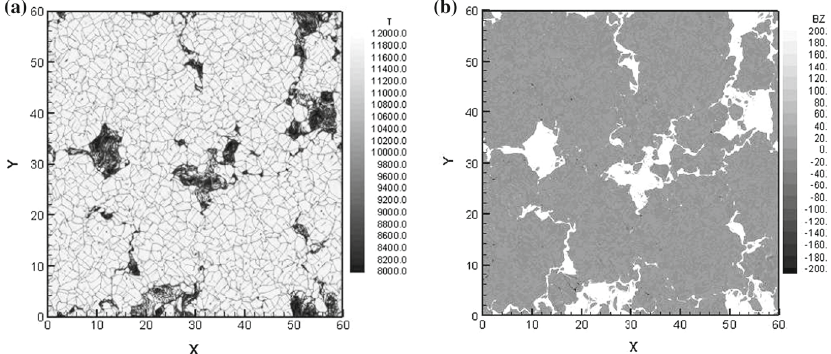
Fig. 16 Horizontal maps of a temperature and b vertical magnetic field fluctuations in the surface layers of local realistic simulations of large-scale MHD convection. Image reprpoduced with permission from Ustyugov (2009), copyright by